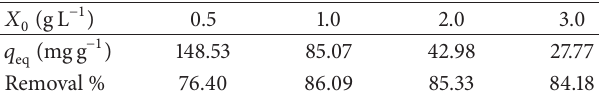
Table 3: The effect of adsorbent dose on the equilibrium uptake capacities and removal % of TB AGLF by sunflower